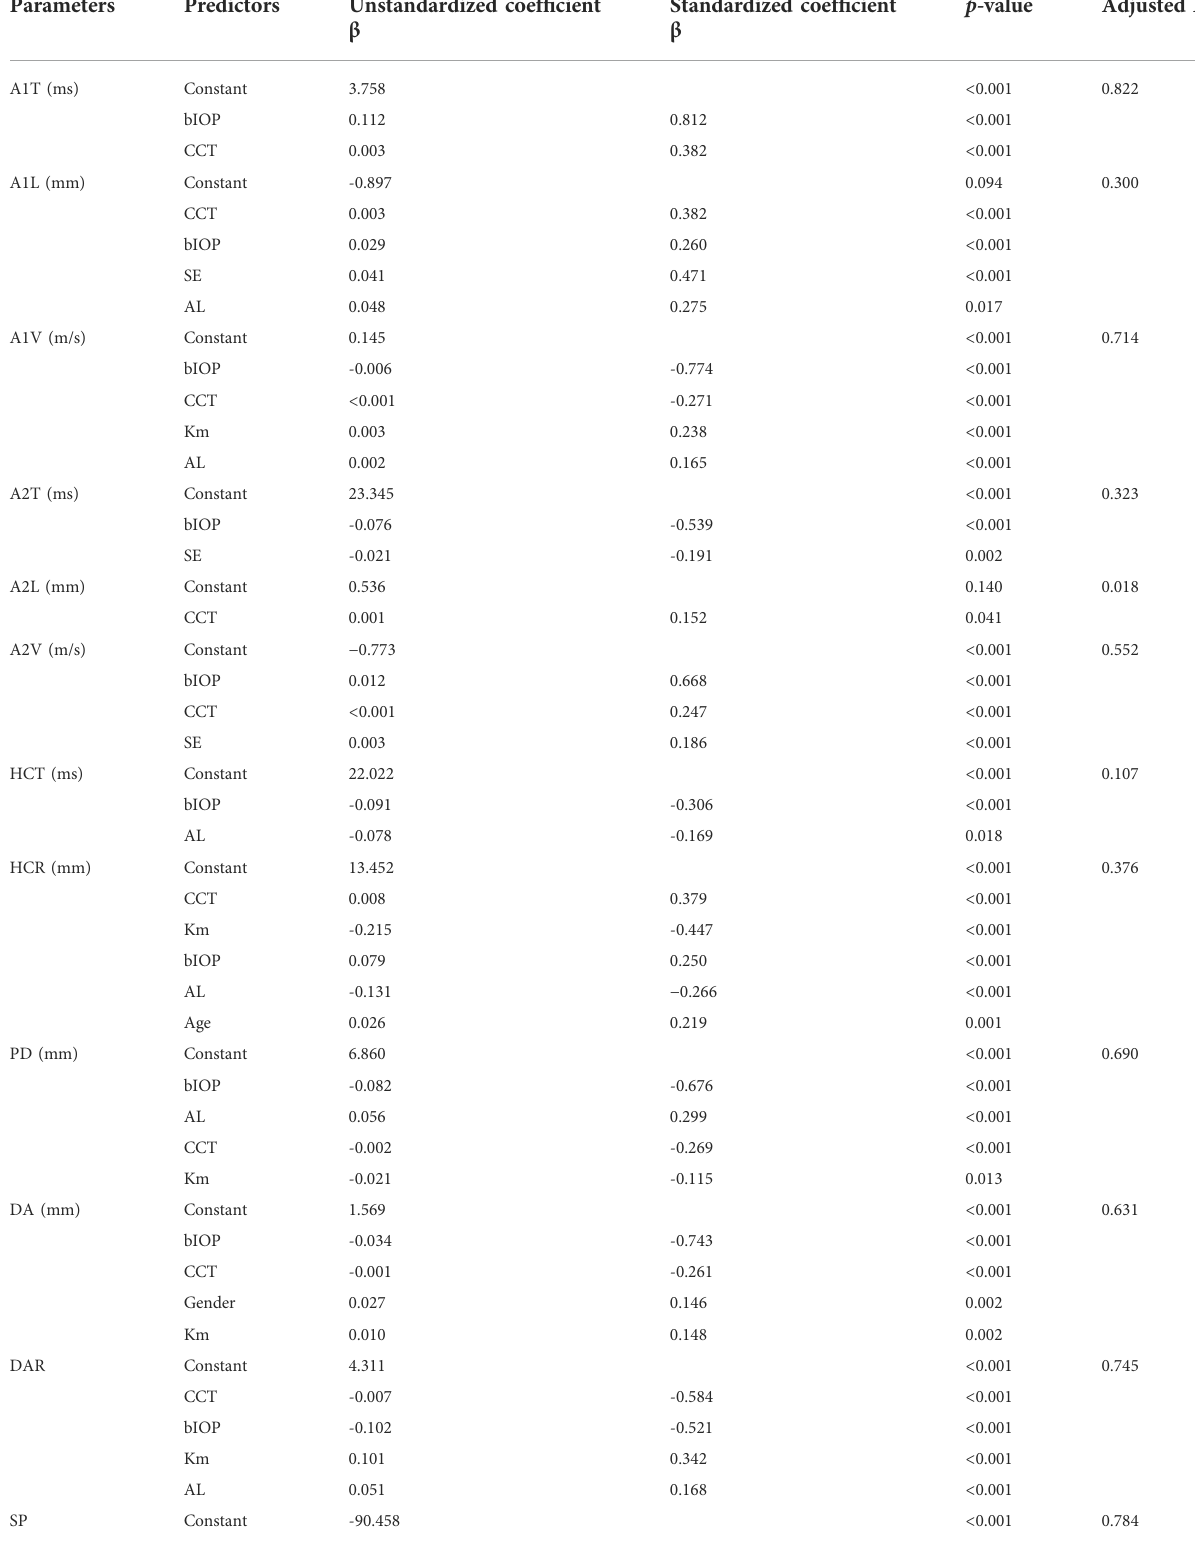
TABLE 2 Multiple regression analysis for variables predicting corneal biomechanical